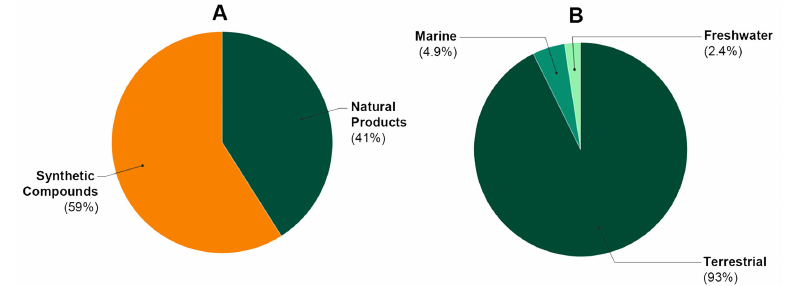
Figure 3. Classification of evaluated substances and environments explored for the research of antileishmanial agents in Colombia. ( A ) Publications classified according to the type of substance tested. ( B ) Publications evaluating natural products subdivided into the habitat